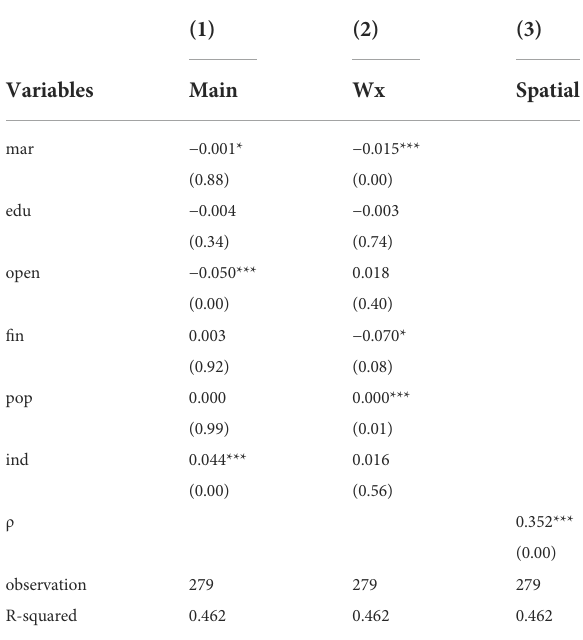
TABLE 6 Baseline regression results.